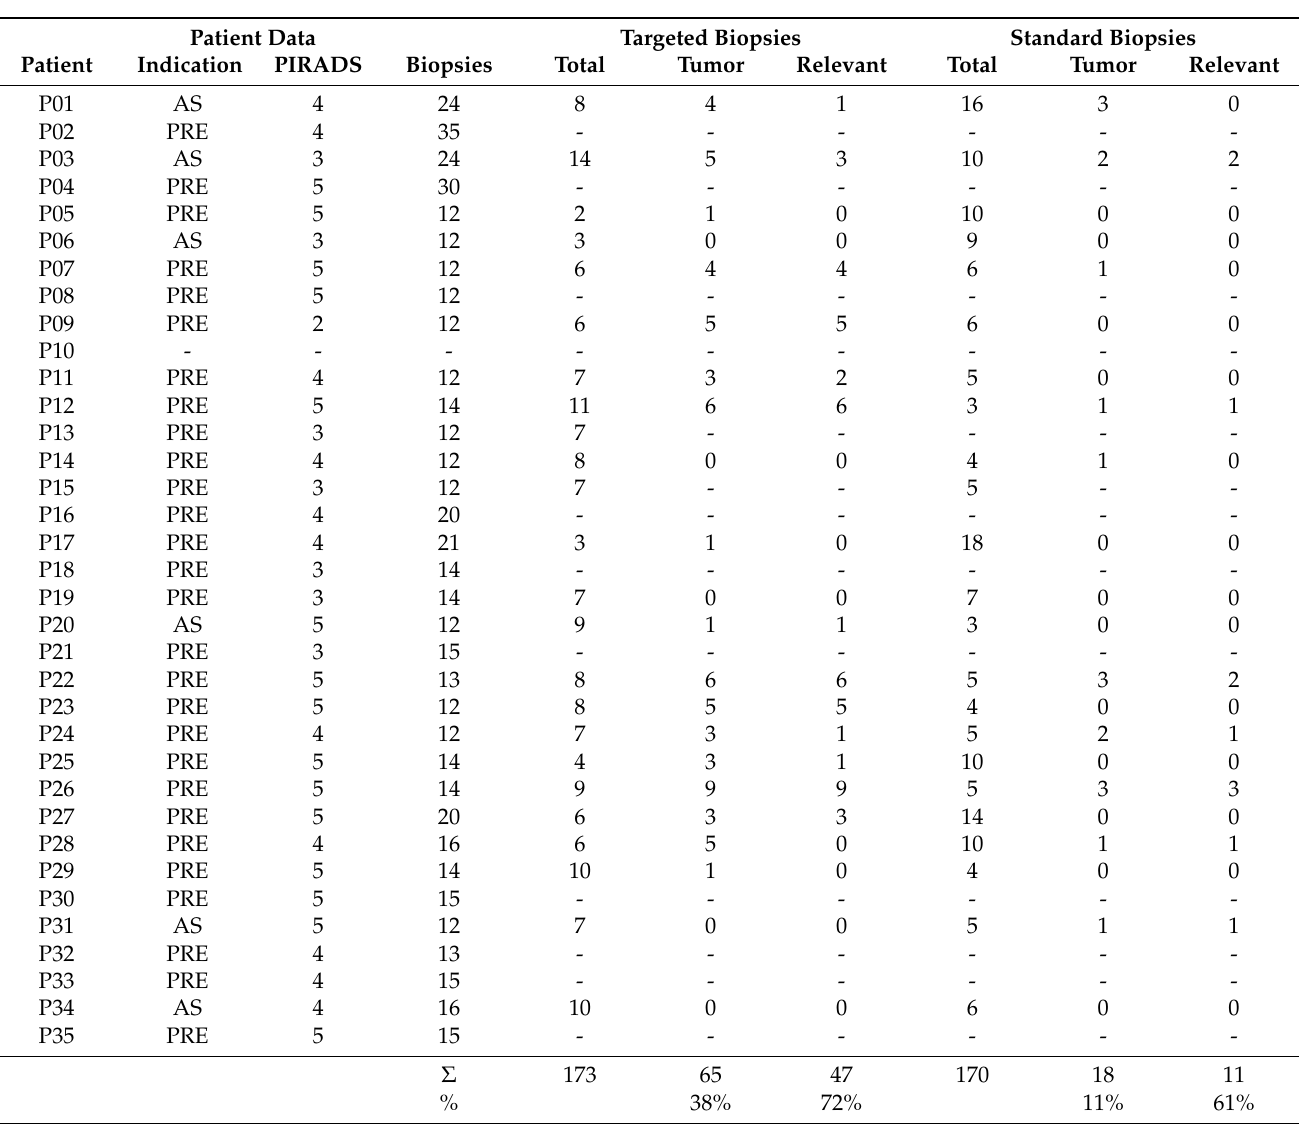
Table 1. Representation of clinically relevant carcinoma in MRI-guided targeted biopsies and system